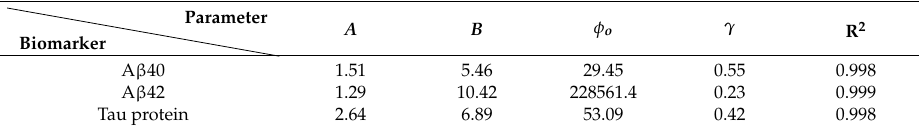
Table 1. Fitted values of parameters A , B , φ o , and γ from Equation (2), and coefficient of determination R 2 for the relationships between IMR signals and biomarker